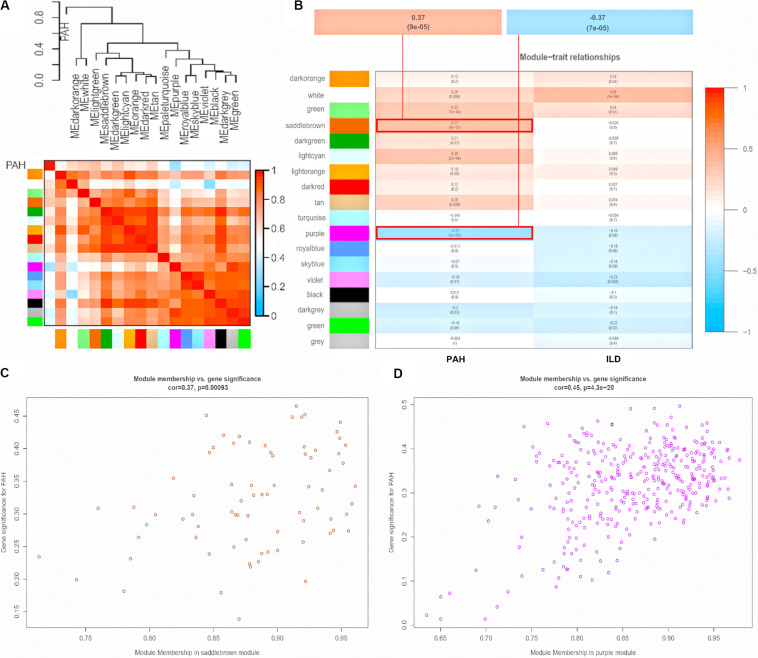
Module-trait relationships. (A) Dendrogram and unsupervised hierarchical clustering heatmap of module eigengenes and PAH. (B) Heatmap of the correlation between module eigengenes and clinical traits. P-value is shown in each color cell coded by the correlation between modules and traits (red indicates positive correlation; blue indicates negative correlation). Scatter plot of module eigengenes in saddlebrown module (C) and purple module (D). PAH, pulmonary arterial hypertension; ILD, interstitial lung disease.